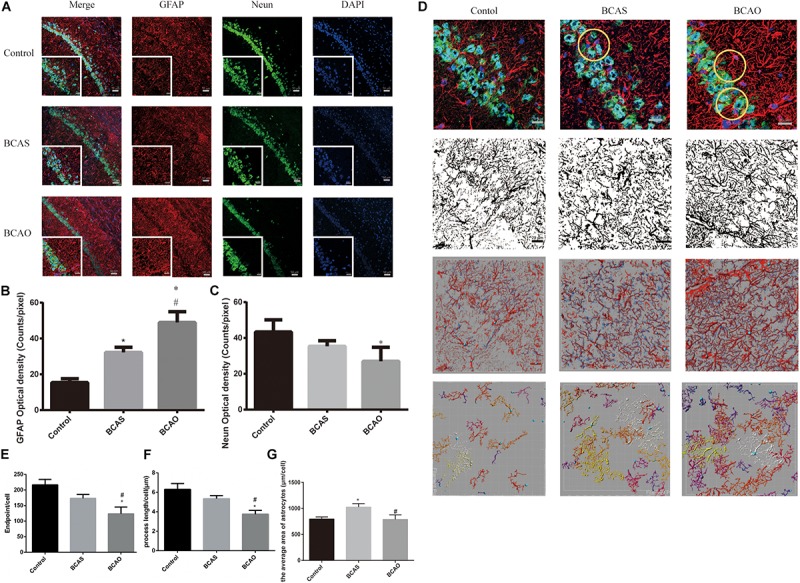
Astrocyte proliferation and neuronal apoptosis in the hippocampal CA1 region of BCAS and BCAO rats (A). GFAP and NeuN expression in the hippocampal CA1 area 30 days after surgery (B and C). The endpoint, the process length and average area of astrocytes. (D–G) Data are expressed as the mean ± SD (n = 6/group). ∗P < 0.05 compared with the control group; #P < 0.05 compared with the BCAS group. BCAS, bilateral common carotid artery stenosis; BCAO, bilateral common carotid artery occlusion; SD, standard deviation; GFAP, glial fibrillary acidic protein; DAPI, 4’,6-diamidino-2-phenylindole.